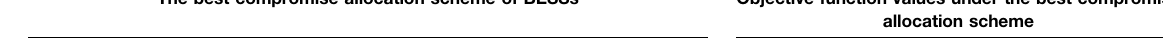
TABLE 3 | Optimization results of two algorithms.